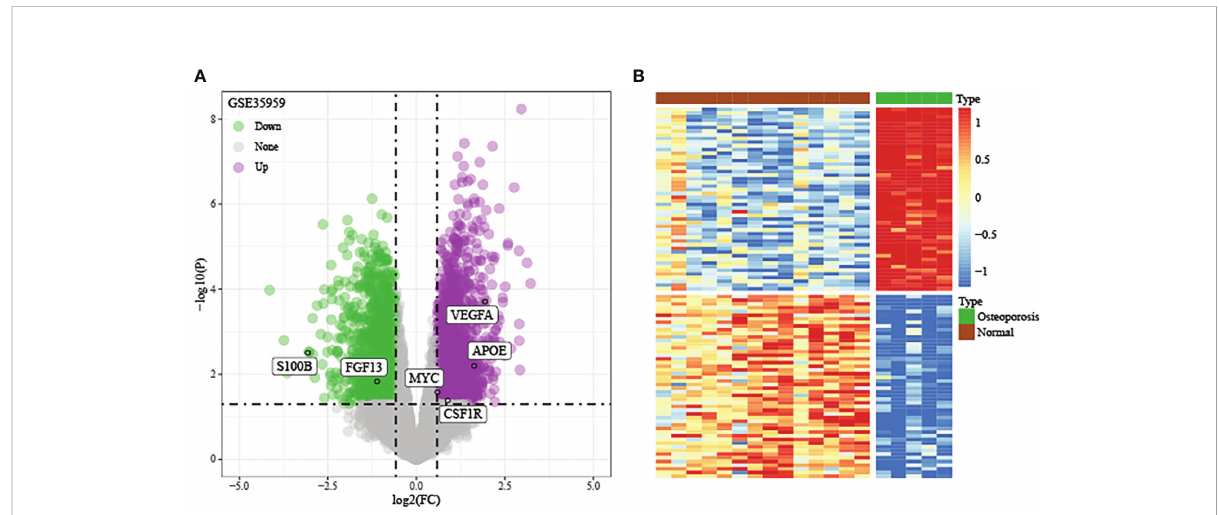
FIGURE 4 Discovery and veri fi cation of DEGs between OP samples and normal samples in training set. (A) Volcano plot of signi fi cantly DEGs. (B) Heat map of DEGs.